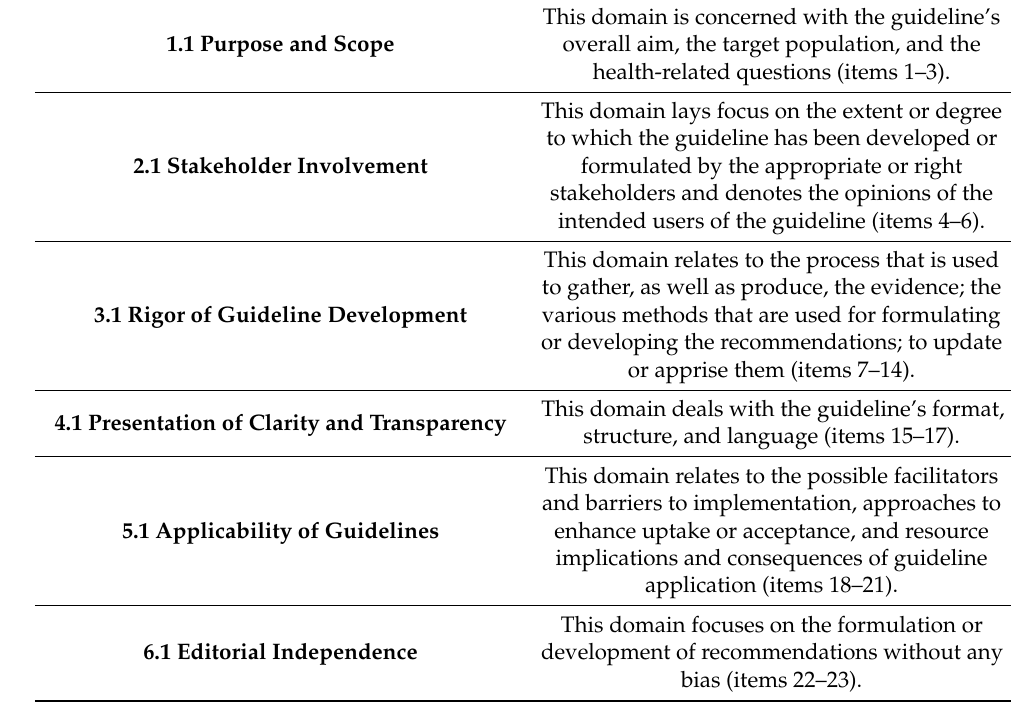
Table 1. AGREE II domains and key